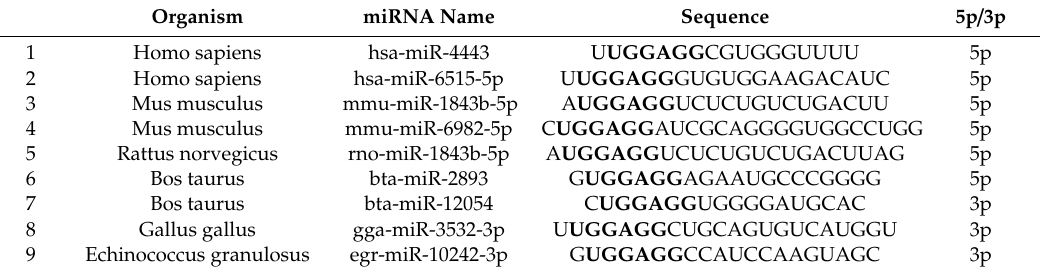
Figure 3. Multiple alignment output showing the human mir-4443 locus and similar loci in 27 primates and 3 other mammals. The identical 6-nucleotide seed region is highlighted. Table 2. Animal miRbase-annotated microRNAs sharing a 6-nucleotide seed (in bold) with miR-4443.